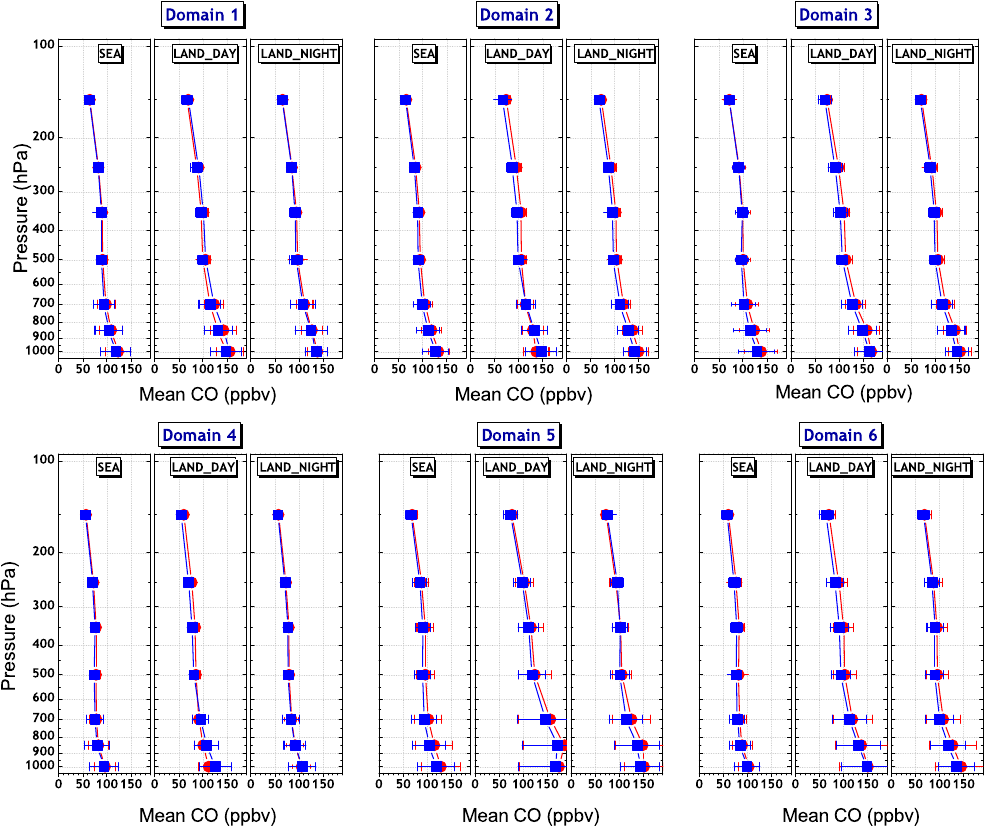
Figure 7. The mean CO vertical profiles in parts per billion by volume (ppbv) deduced from MOPITT V3 CO TOTCOL_ANALYSES (blue) compared to the operational MOPITT V3 observations (red). Both data sets are averaged over August 2008, over all the domains defined in Fig. 6, and are associated with their corresponding standard deviations.